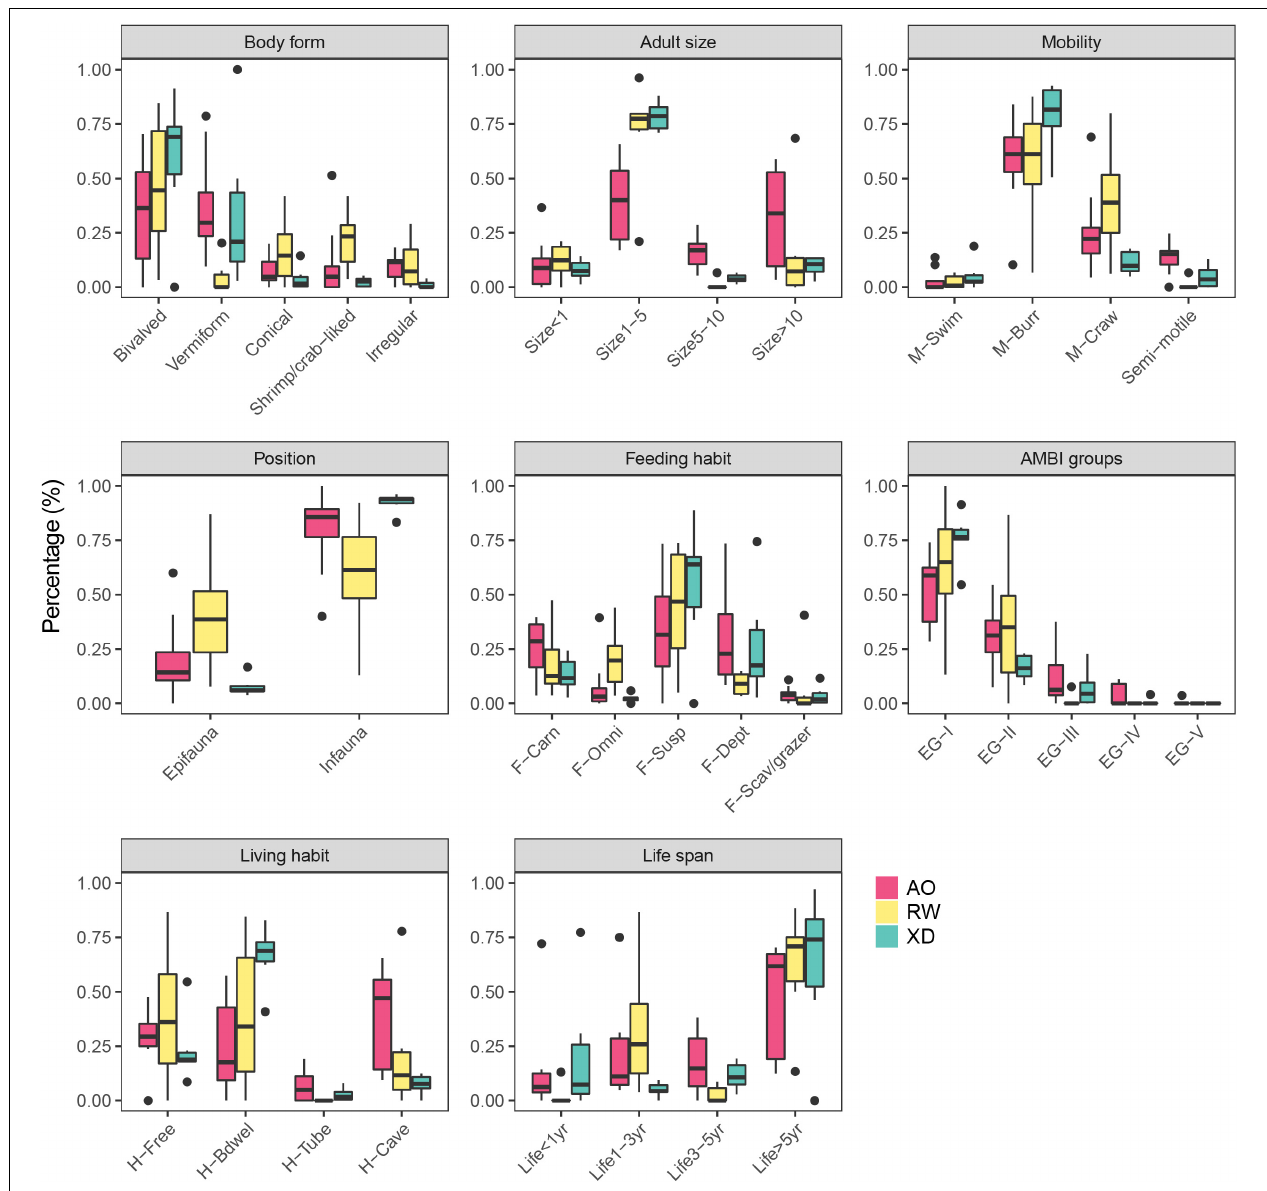
FIGURE 2 | Boxplot of the CWM (Community Weight Mean) values of each compiled functional trait calculated for each intertidal zone. For full labels of traits modalities, see Table 1